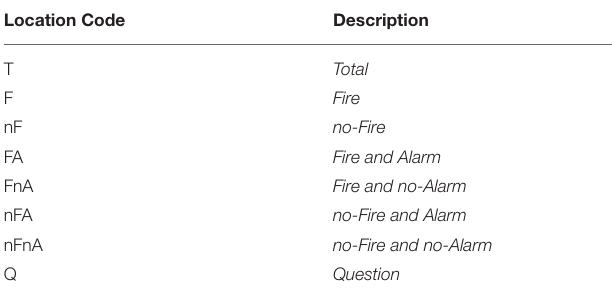
TABLE 2 | Coding scheme for the locations (i.e., buttons) on the